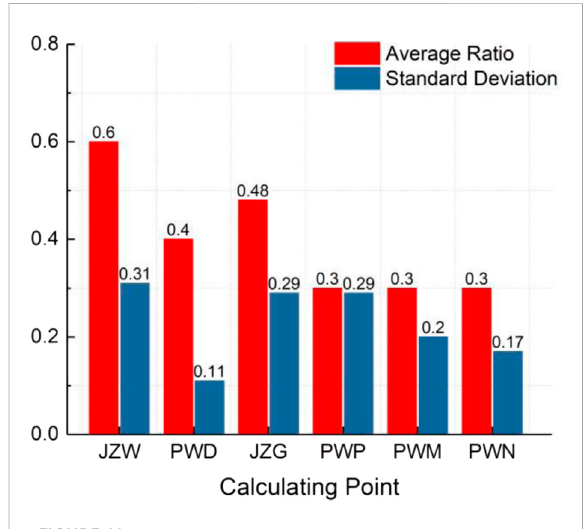
FIGURE 11 PGV contribution ratio of high-frequency ground motion to broadband ground